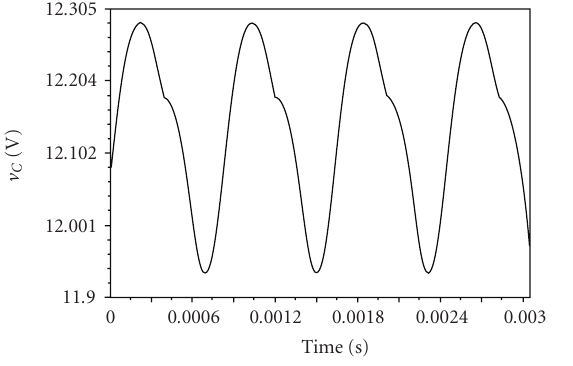
Figure 10: 4- T subharmonic operation. ( E = 41V): phase plane.